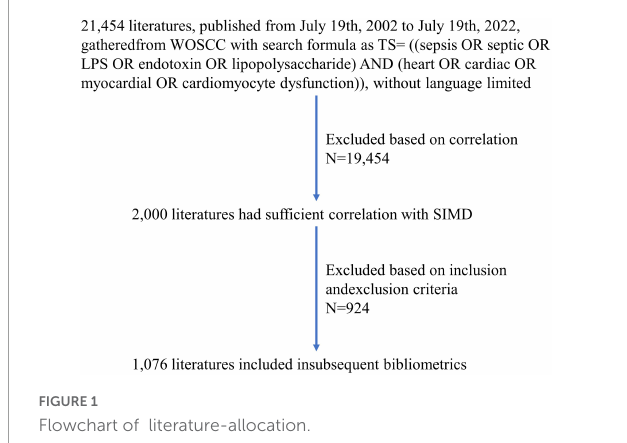
FIGURE1 Flowchart of